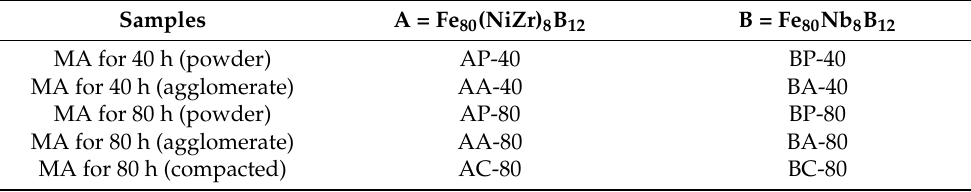
Table 1. Samples analyzed in the research with the corresponding label. MA signifies mechanical alloying.